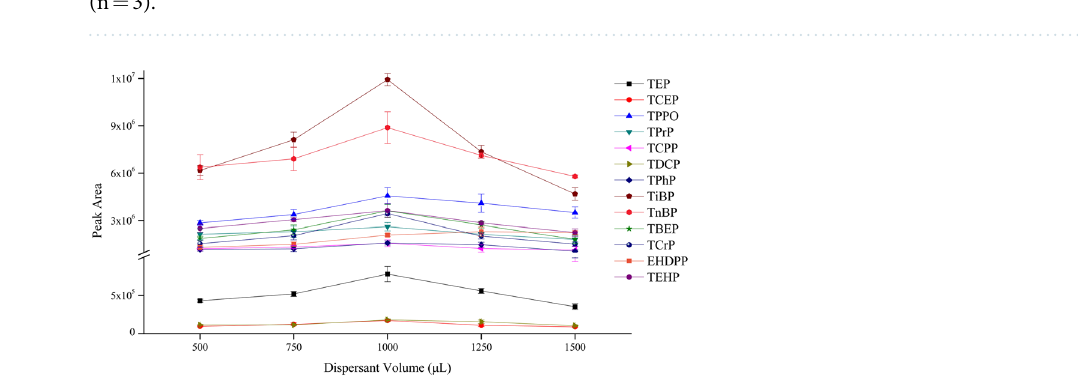
Figure 4. The efficiency of different dispersant volumes on the extraction of OPEs from aqueous samples (n =